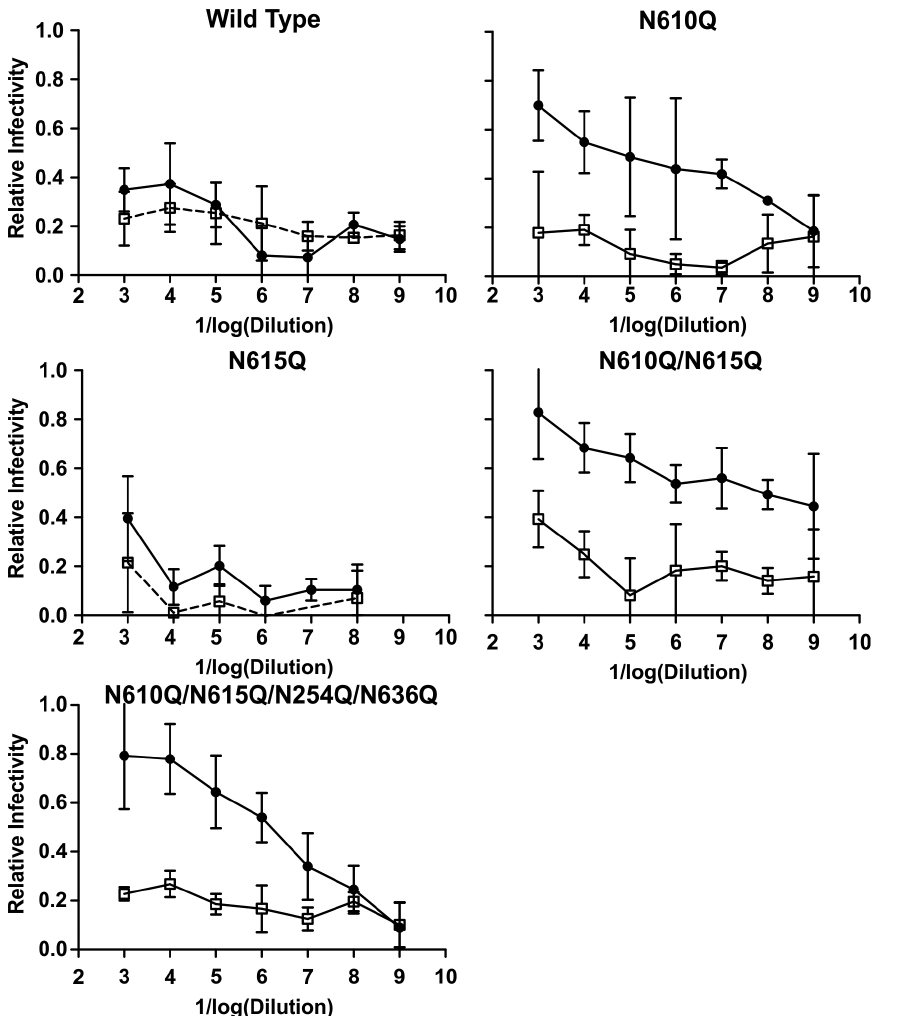
Figure 3. Induction of neutralizing antibody responses by mutant forms of CM243 Env containing deglycosylation mutations in NZW rabbits. There were five groups of three animals each: the groups were wild type gp140 (CM243), N610/615/624/636Q, N615Q, N610/615Q and N610Q. Rabbits were immunized four times with the indicated mutant gp140s. and sera were obtained for testing 2 weeks after the fourth doses. Sera were tested in serial two-fold dilutions for neutralization of virus pseudotyped with CM243 Env. Results obtained from the gp140 immunized rabbits are shown in black circles and for control (adjuvant only) rabbits in open circles. Results shown are means and standard deviations of three separate assays, each in triplicate, with sera collected following the final immunization.